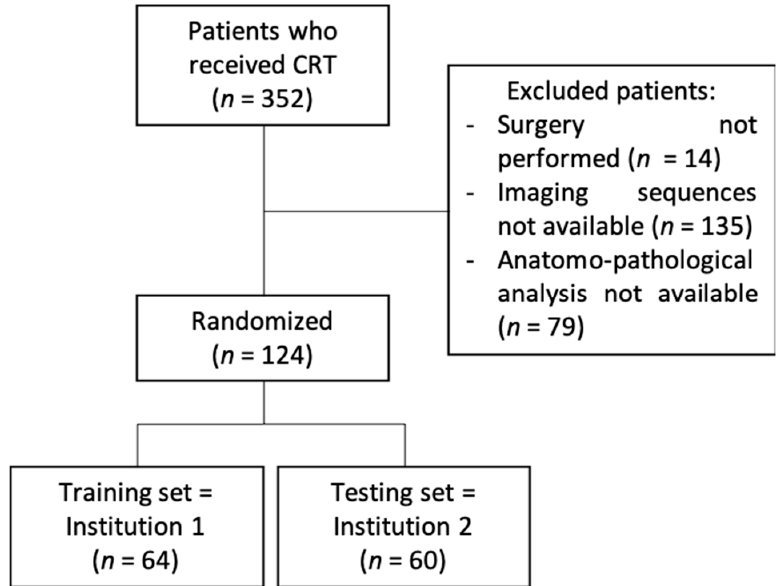
Figure 1. Flowchart. Table 1. Initial